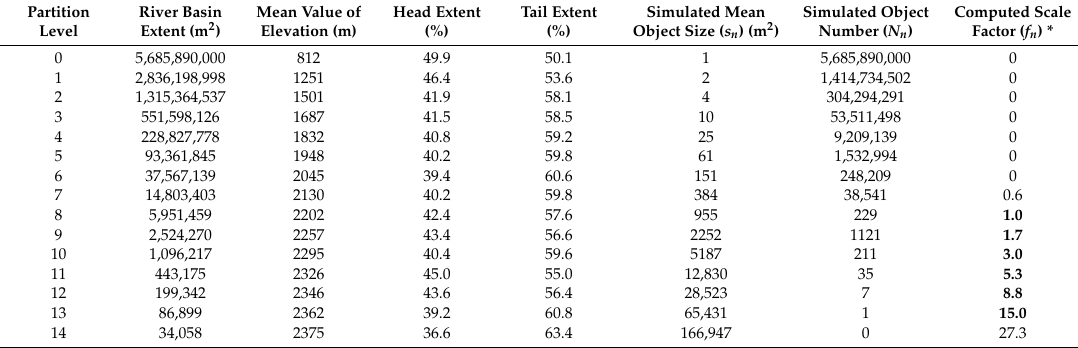
Table 4. Partial and final outputs for elevation in the Acheloos river basin; 0-partition level corresponds to the original elevation